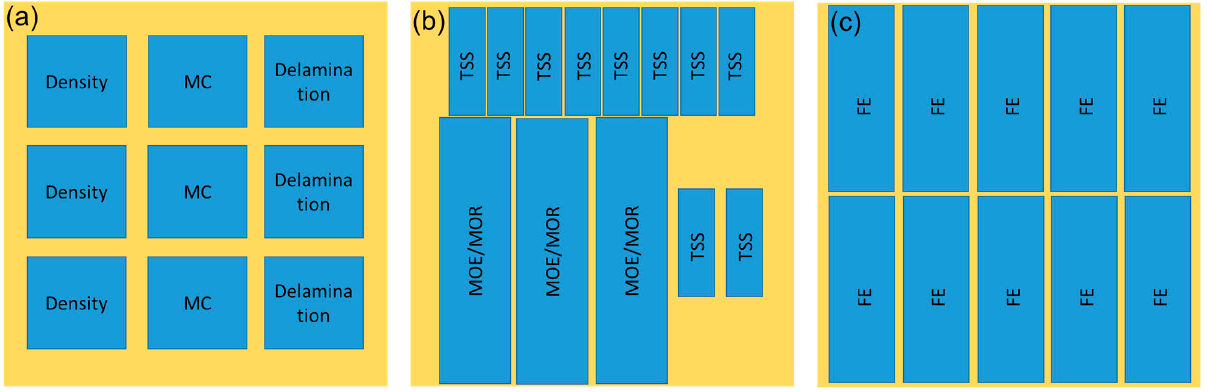
Figure 1. The cutting plan of the test specimens of plywood. ( a ) Physical test sample, ( b ) mechanical test sample, ( c ) FE test